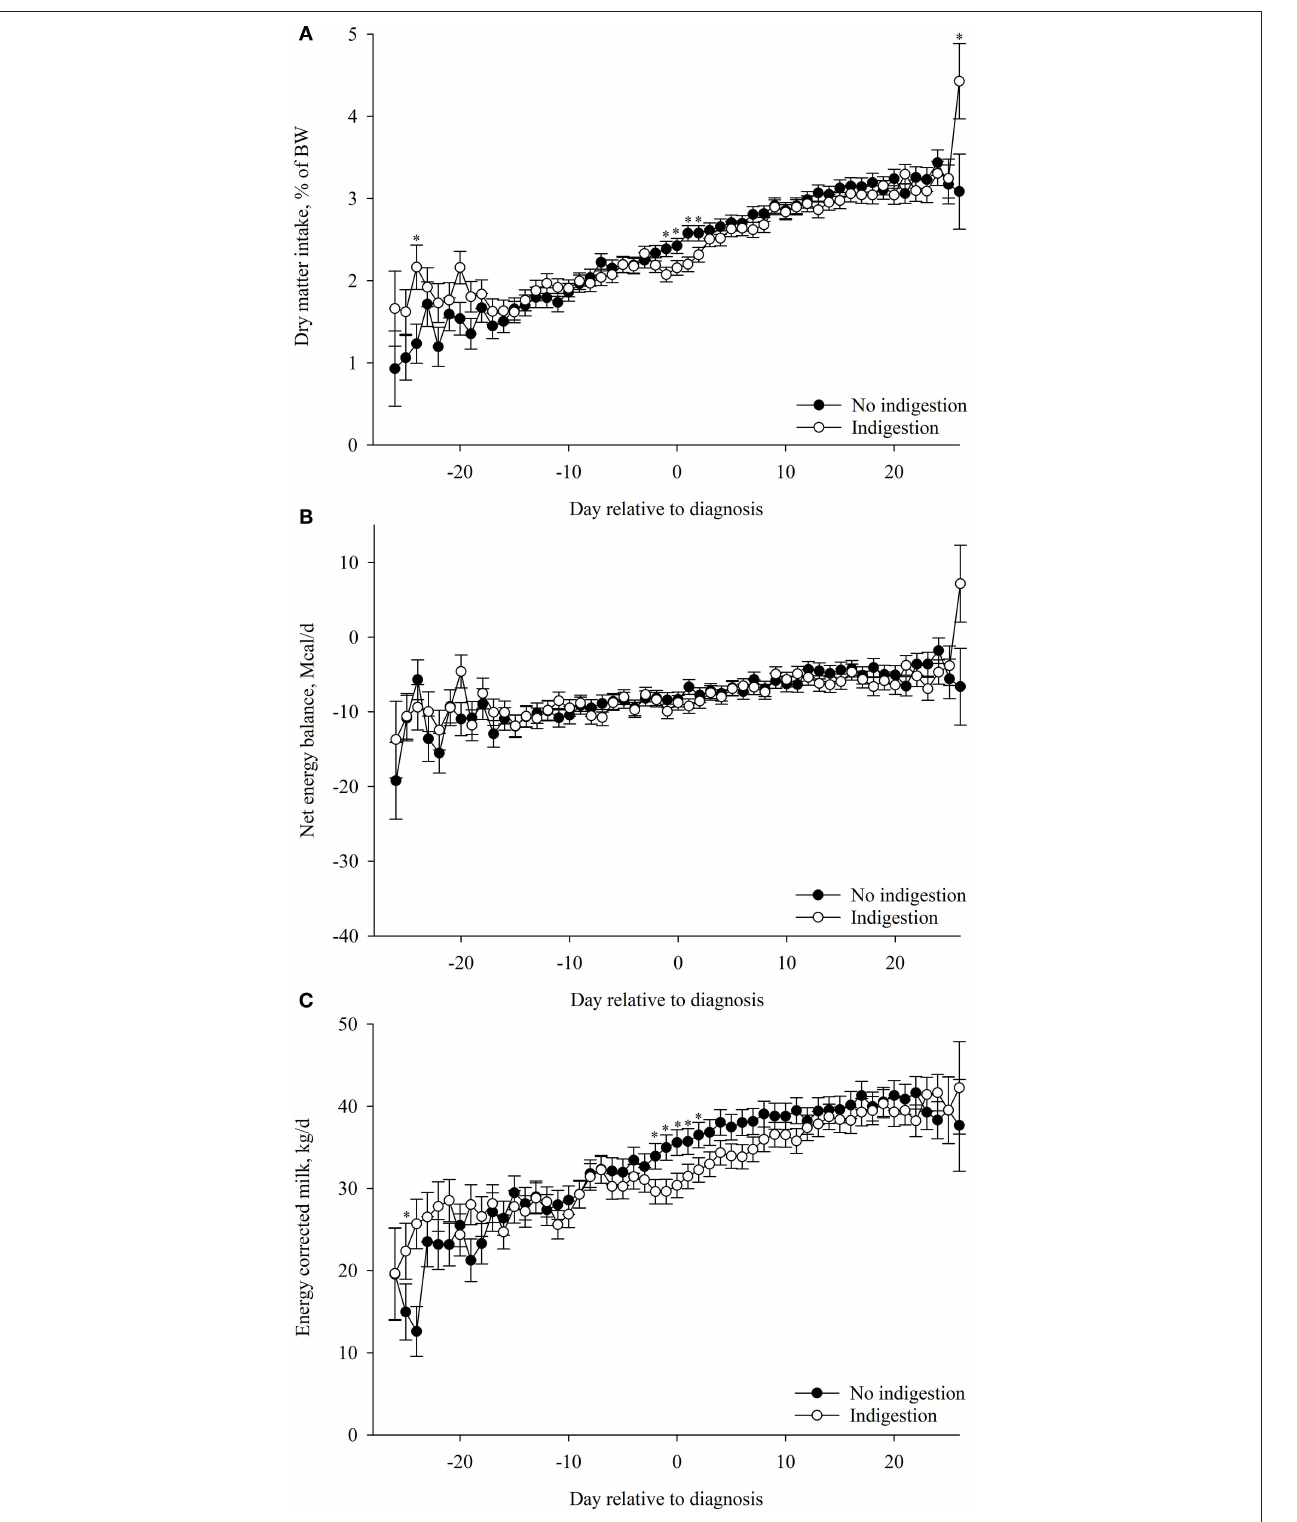
FIGURE 5 | Association of indigestion postpartum ( n = 118) with (A) dry matter intake (DMI, %BW), (B) net energy balance (EB, Mcal/day), and (C) energy-corrected milk (ECM, kg/day) during the postpartum period (from − 26 to 26 days relative to diagnosis). Values are least square means ± SEM. Postpartum DMI (%BW): indigestion, p = 0.58; day relative to parturition, p < 0.01; and the interaction between indigestion and day, p < 0.01. Postpartum EB: indigestion, p = 0.80; day relative to parturition, p < 0.01; and the interaction between indigestion and day, p = 0.38. ECM: indigestion, p = 0.72; day relative to parturition, p < 0.01; and the interaction between indigestion and day, p < 0.01.* p ≤